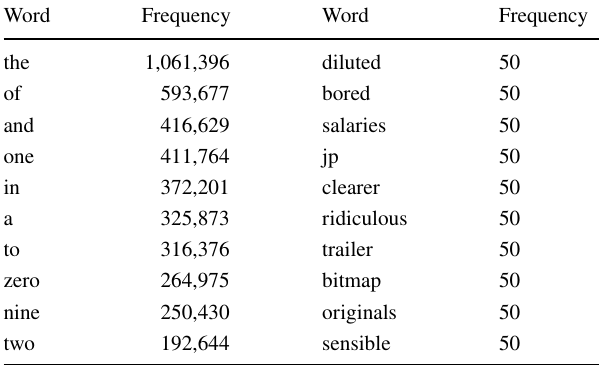
Table 2 Examples of high-frequency (left) and low-frequency (right) words